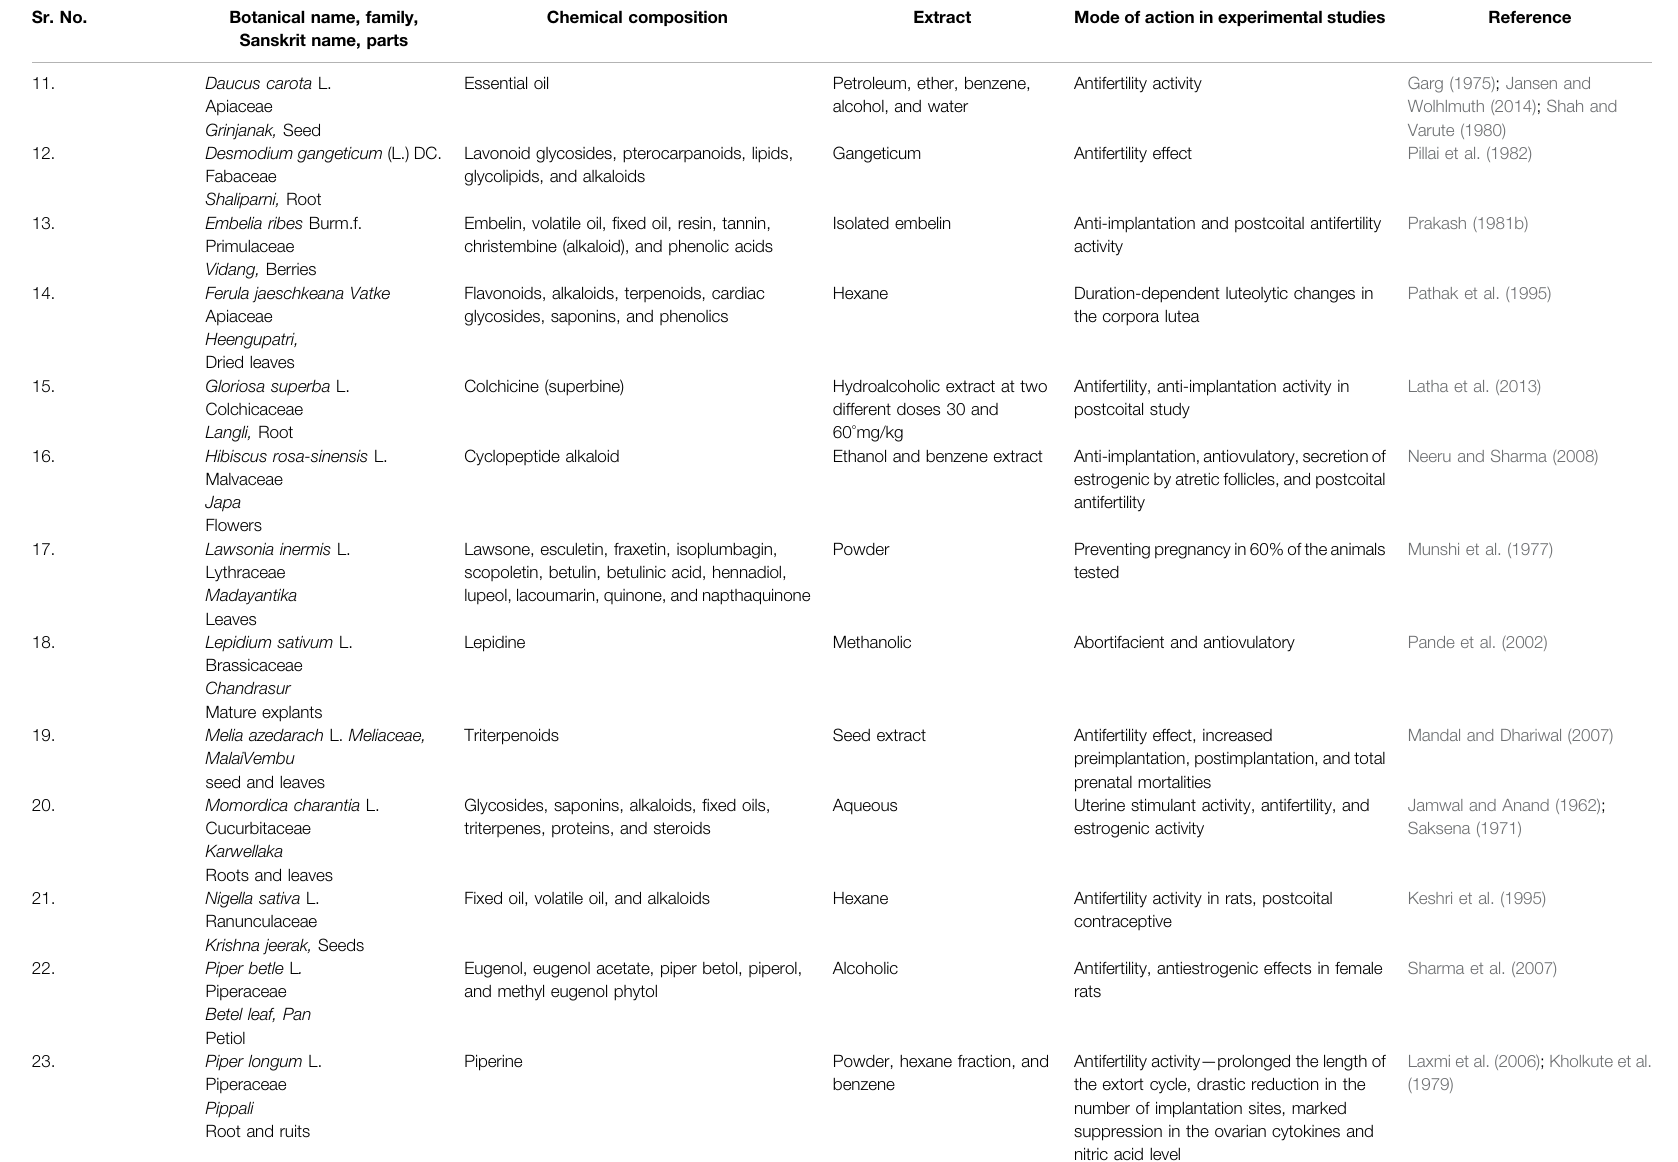
TABLE 2 | ( Continued ) Medicinal plants and their phyotoconstituents validated for various female/male contraceptive activities. Different contraceptive activities studied on medicinal plants could be categorized as follows. Female contraceptive activities: (2A) anti-implantation activity, (2B) aborti fi cation, (2C) antifertility, (2D) antiovulatory, and (2E) antiestrogenic activity. Male contraceptive activities: (2F) antispermatogenic, (2G) spermicidal, and (2H) antiandrogenic